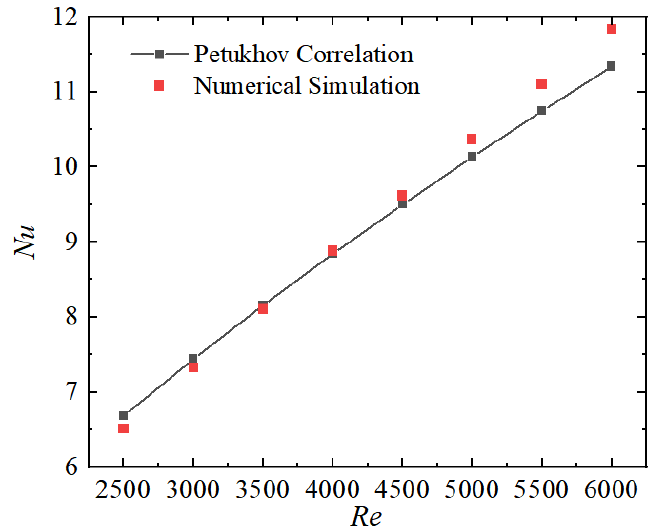
Figure 7. The verification of the numerical model.